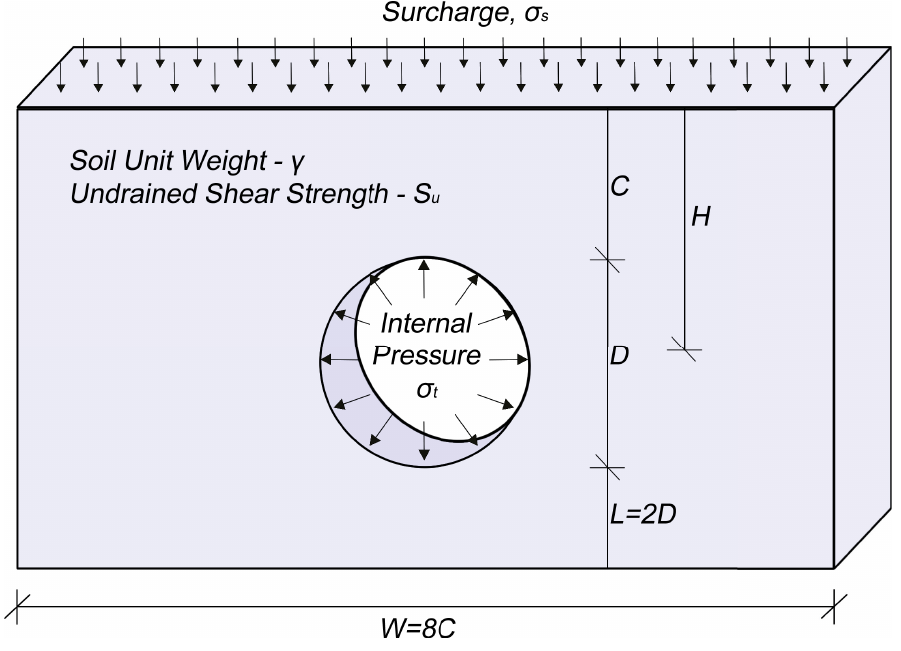
Figure 2. Problem de fi